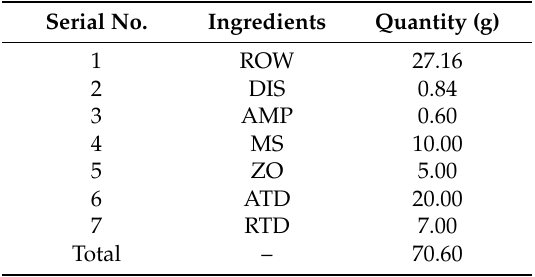
Table 1. Nano mill Slurry